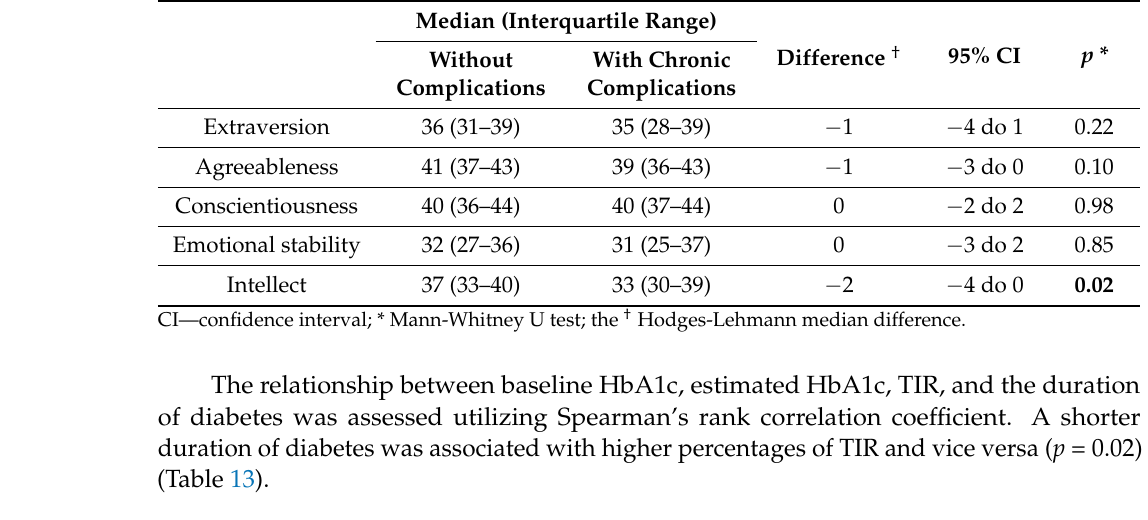
Table 11. Differences in personality dimensions related to the occurrence of